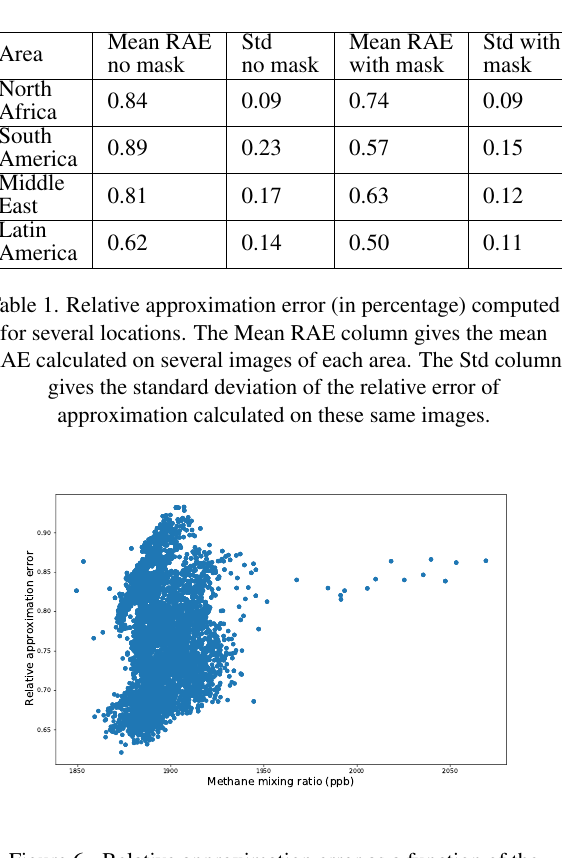
Figure 6. Relative approximation error as a function of the methane mixing ratio in particles per billion (ppb). Each dot in the figure corresponds to a